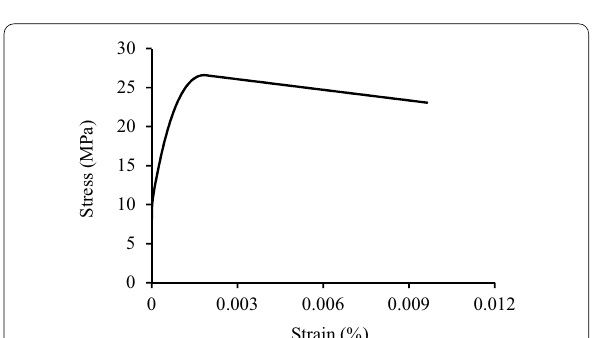
Fig. 21 Compressive stress–strain curve of concrete (Lubliner et al., 1989).